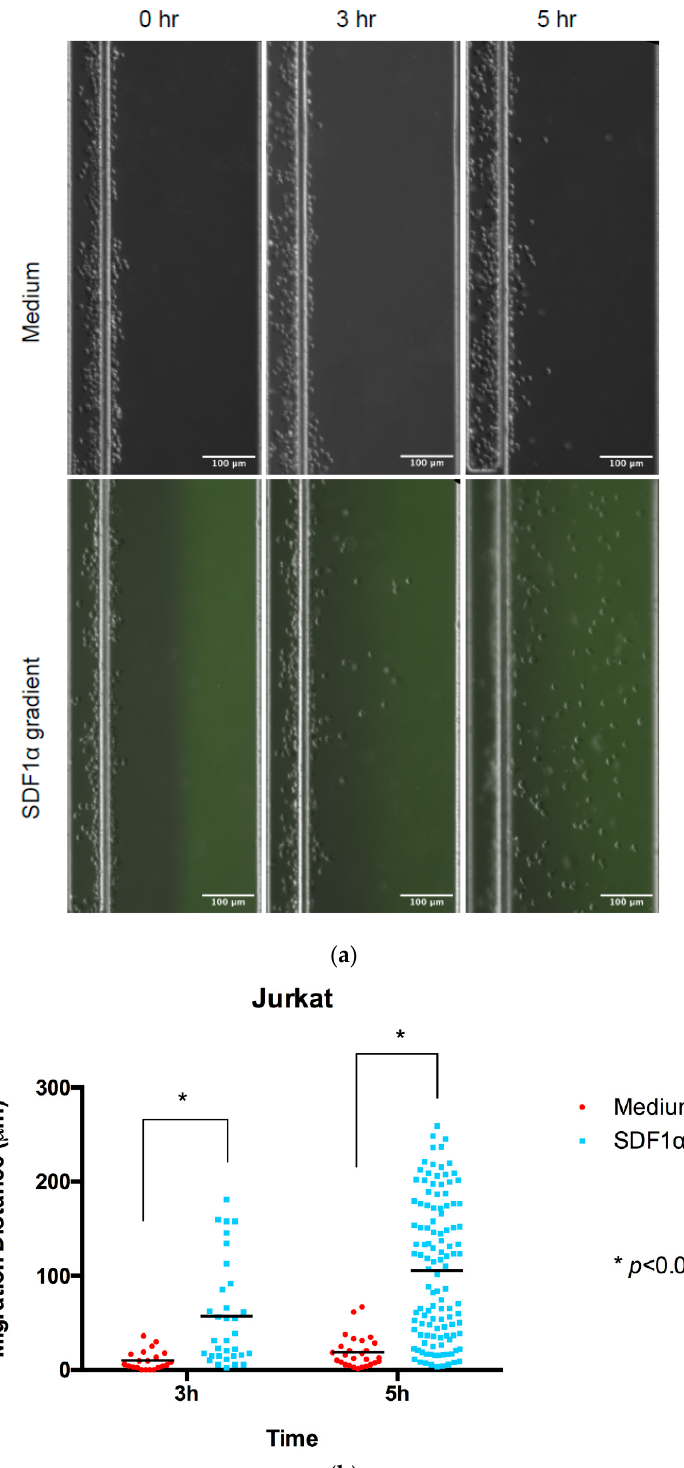
Figure 2. Chemotaxis of Jurkat cells in multi-channel radial microfluidic device. ( a ) Representative Jurkat cells distribution images in the channel at the beginning and the 3 h and 5 h chemotaxis experiment in a 100 nM SDF-1 α gradient. ( b ) Quantitative migration distance analysis for the experiments in ( a ). The results are presented as the average value ± standard error of the mean (SEM). * indicates p <